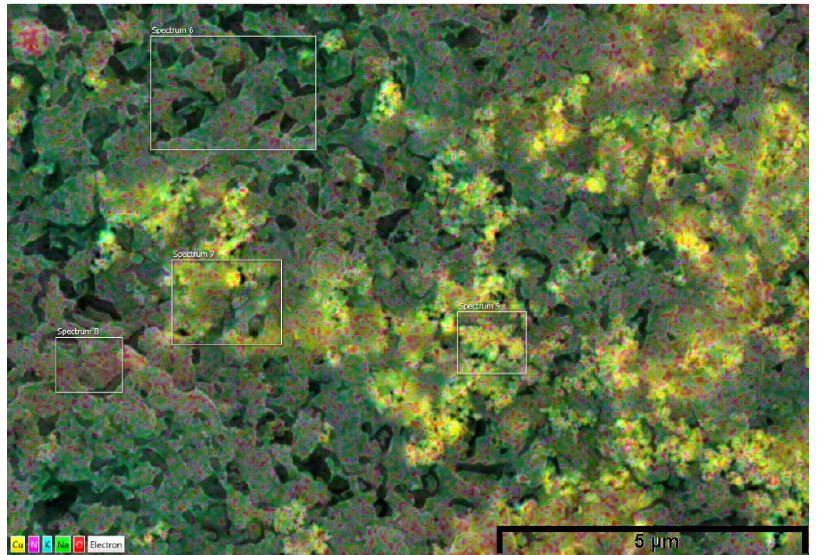
Figure 4. Energy dispersive X-ray (EDX) mapping of 0.1 wt % CuO (Yellow—Copper, Violet—Nitrogen, Blue—Potassium, Green—Sodium, and Red—Oxygen).